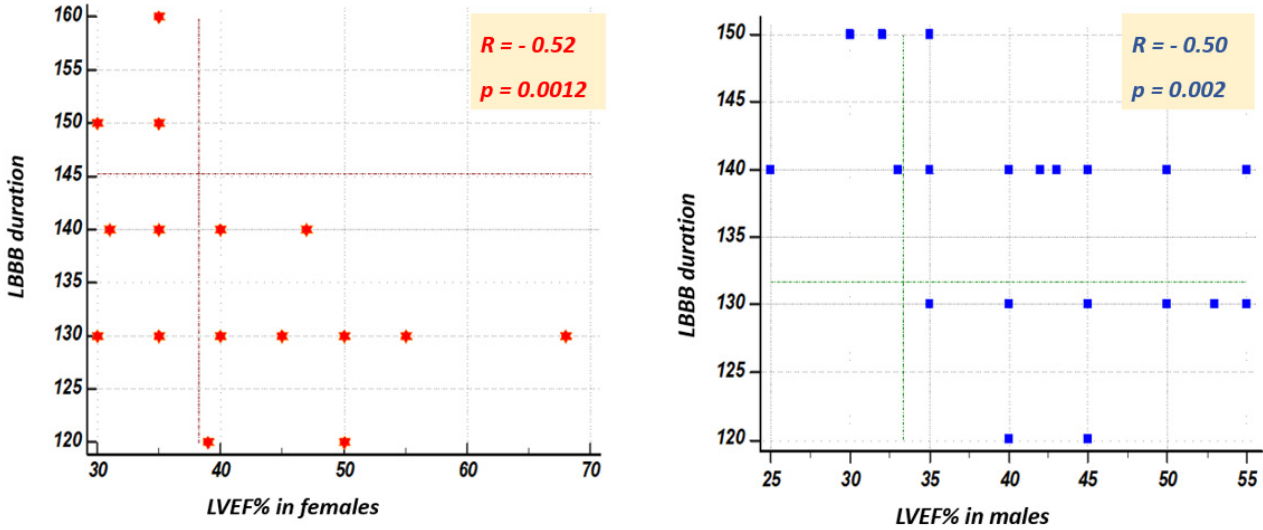
Figure 6. Correlation between the duration of the LBBB-QRS complex and LVEF (%) depending on the gender of the patient.